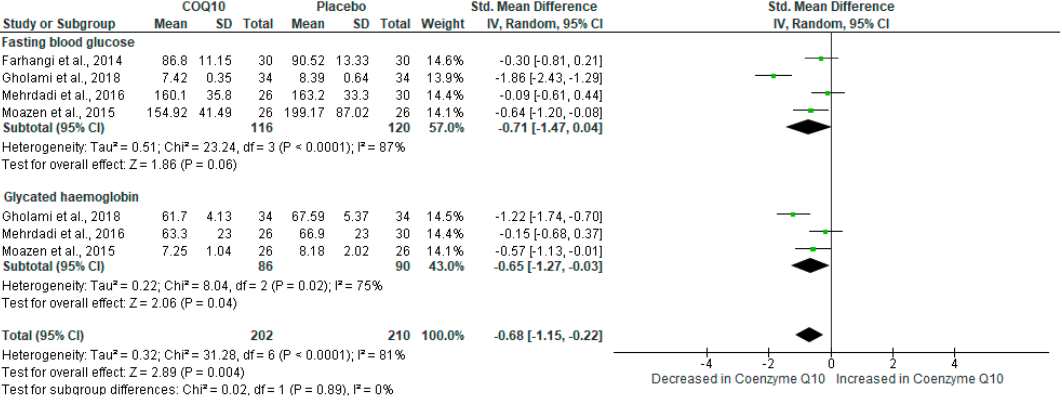
Figure 5. The impact of coenzyme Q 10 (CoQ 10 ) supplementation on basic metabolic markers such as fasting plasma glucose (FPG) levels and glycated hemoglobin (HbA1c).